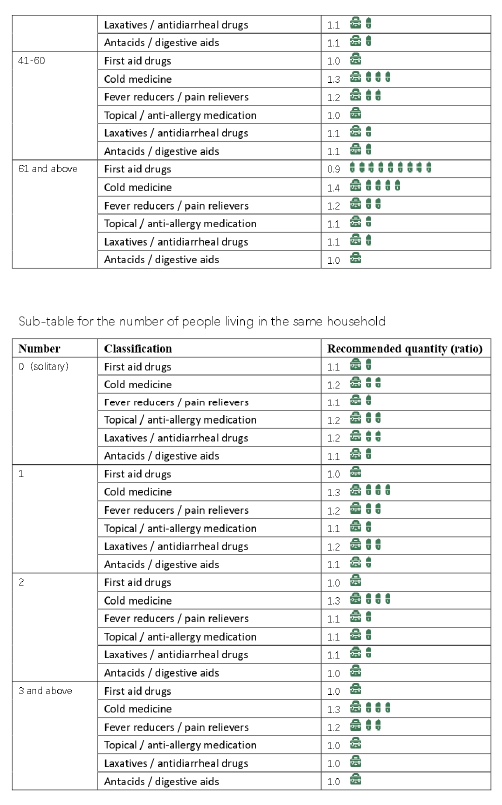
Figure 19. Final practical domestic-medication system.